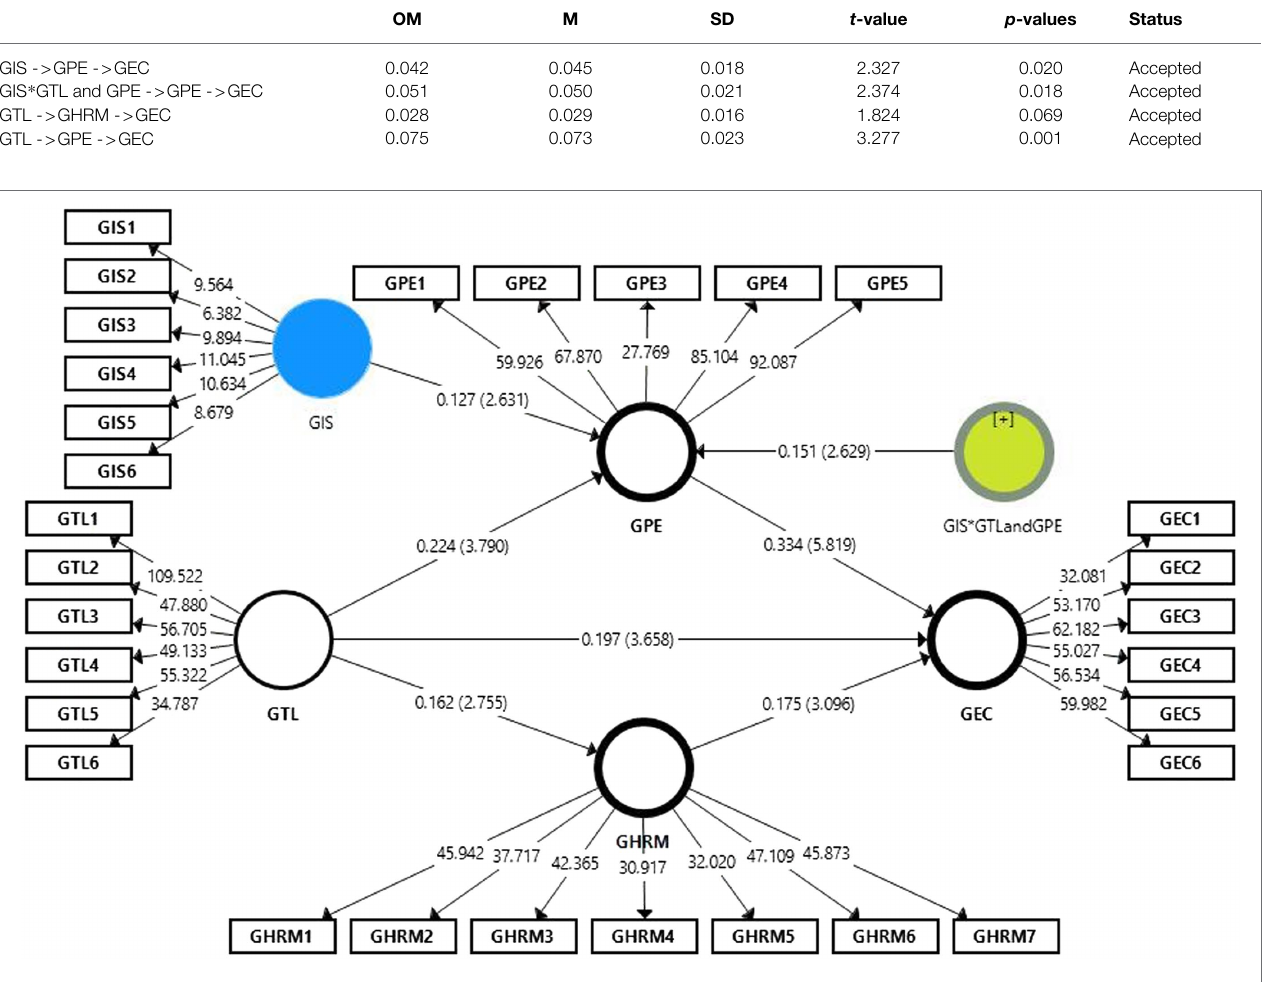
FIGURE 2 | The mediating effect.